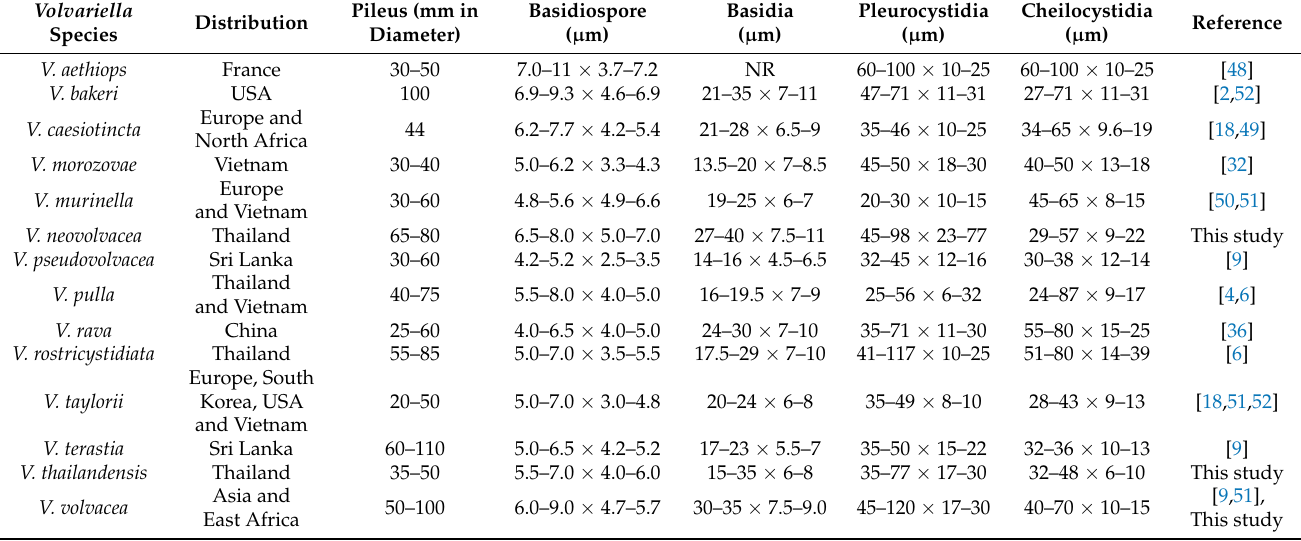
Table 2. Comparison of V. neovolvacea and V. thailandensis with the closely related